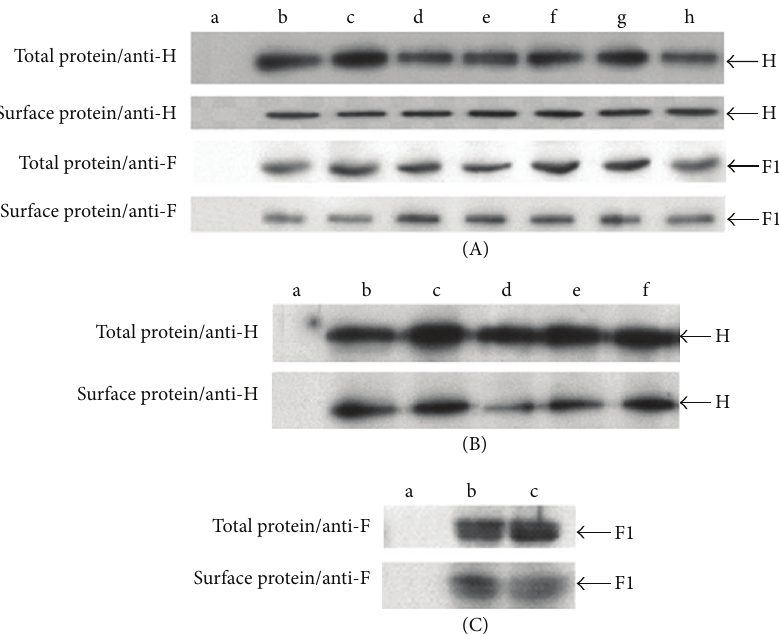
Figure 2: Determination of cell surface expression of escape mutant glycoproteins. Vero-SLAM cells infected with the escape mutant viruses or transfected with phCMV plasmids expressing the mutated H or mutated F proteins in the presence, when necessary, of the antifusion tripeptide FIP were lysed 1 day after infection (or after transfection) with or without previous biotinylation to extract the surface proteins or the total proteins, respectively. Western blot analysis was then done to detect the H and F proteins using anti-H mAb BH195 and anti-F mAb CB. (A) Cells infected with escape mutant viruses: (a) noninfected cells, (b) normal Halle, (c) Halle-CD46 1.2, (d) Halle-CD46 1.3, (e) Halle-CD46 3.3, (f) Halle-SLAM 1.2, (g) Halle-SLAM 2.3, and (h) Halle-SLAM 5.1. (B) Cells transfected with phCMV plasmids expressing H proteins of escape mutants: (a) normal Halle-F (control), (b) normal Halle-H, (c) Halle-CD46 1.3 H, (d) Halle-CD46 3.3 H, (e)